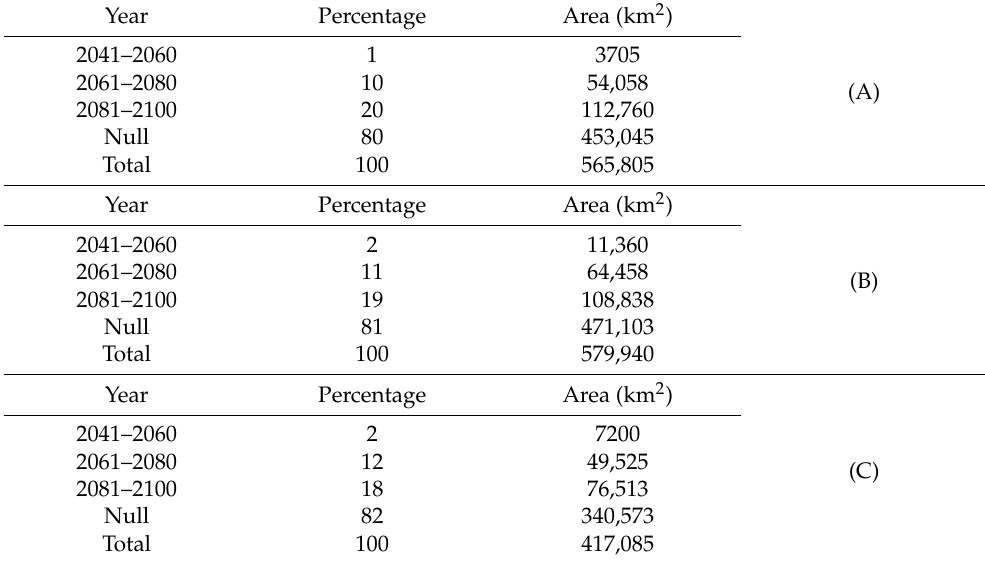
Table 7. Percentages and flood areas for the Conservative scenario SSP2-RCP4.5: (A) agricultural area, (B) urban area, and (C) natural resources